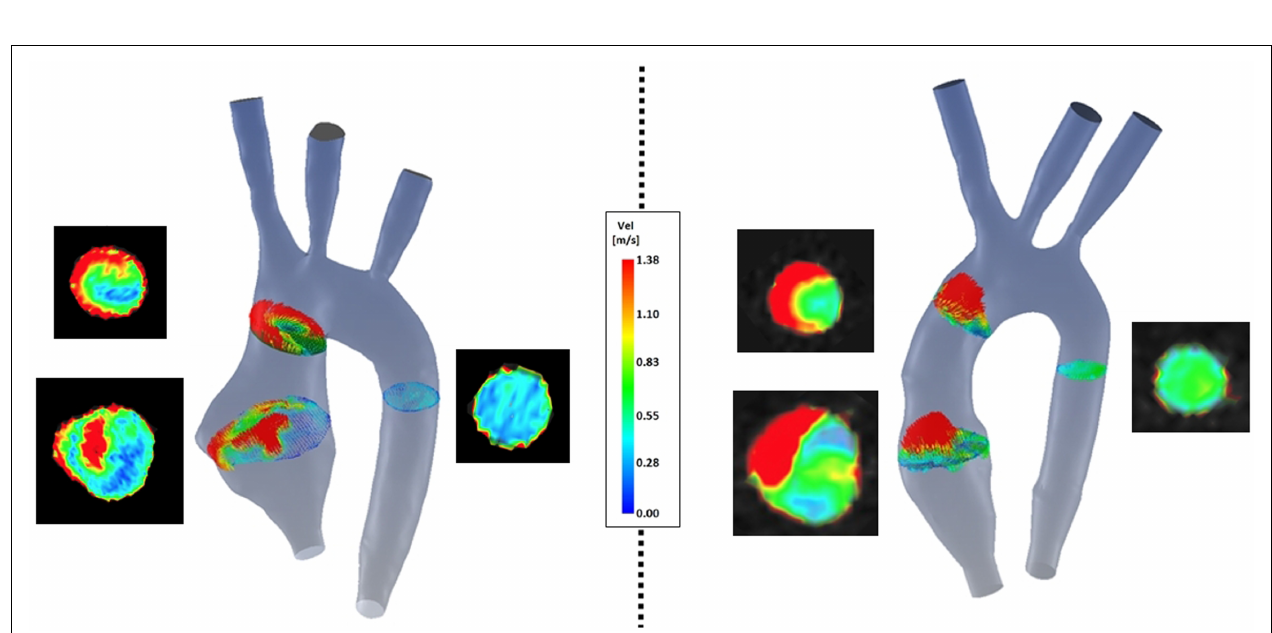
FIGURE 8 | Comparison of velocity vectors at three cross-sections along the aorta in both TGA ( left ) and control ( right ) anatomies . The corresponding velocity data at the same planes extracted from the experimental 4D CMR are shown next to each model, showing good agreement on the same velocity